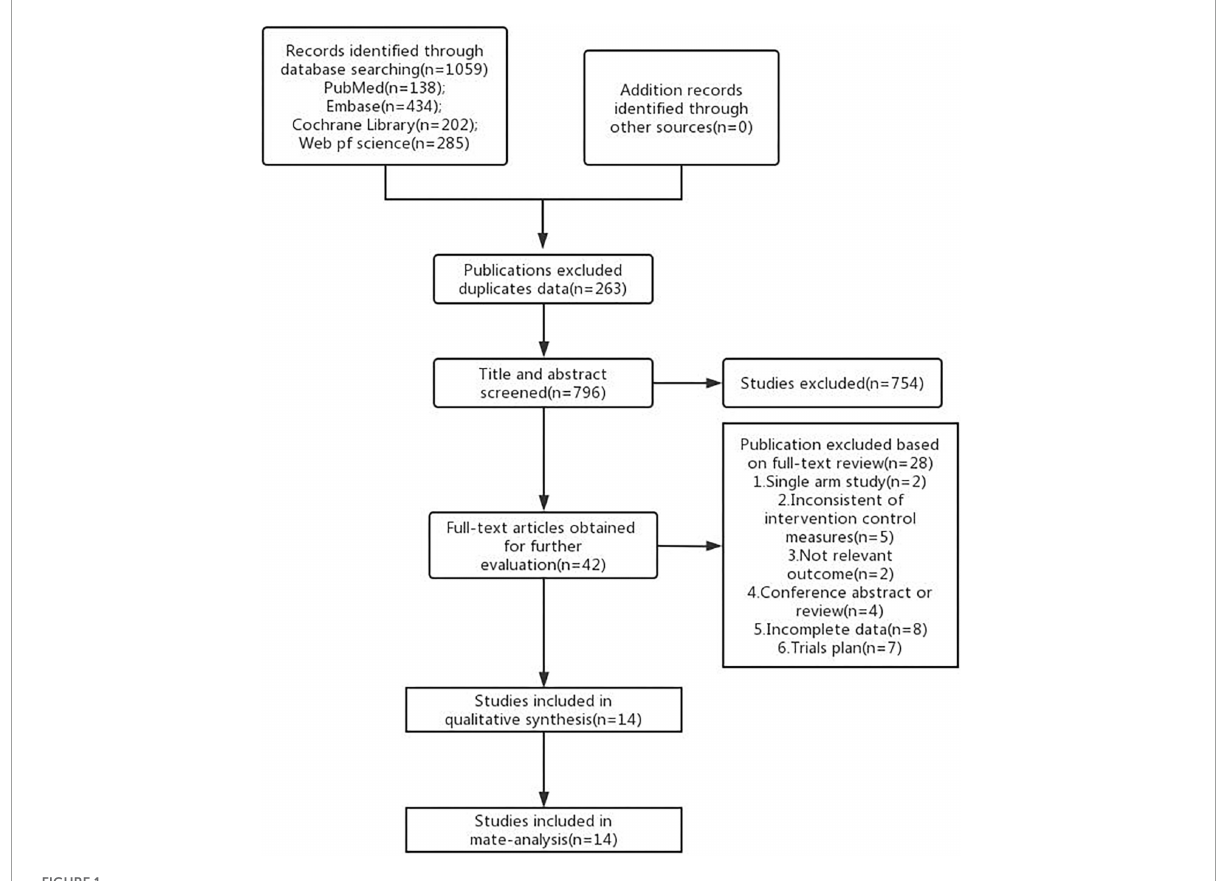
FIGURE1 Diagram of literature searching and selection for